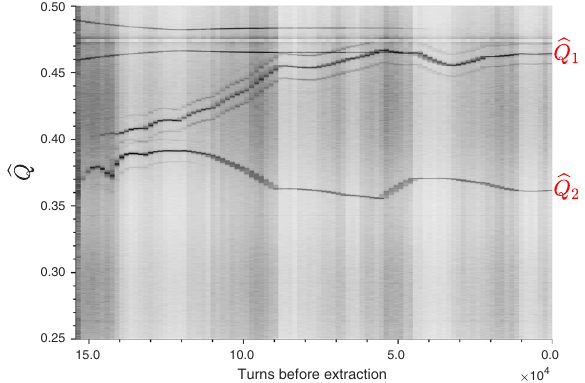
FIG. 10. FFT spectra of turn-by-turn beam position after coherent betatron oscillations are excited by a kicker as a function of turns before extraction. The measured tunes are visible as black